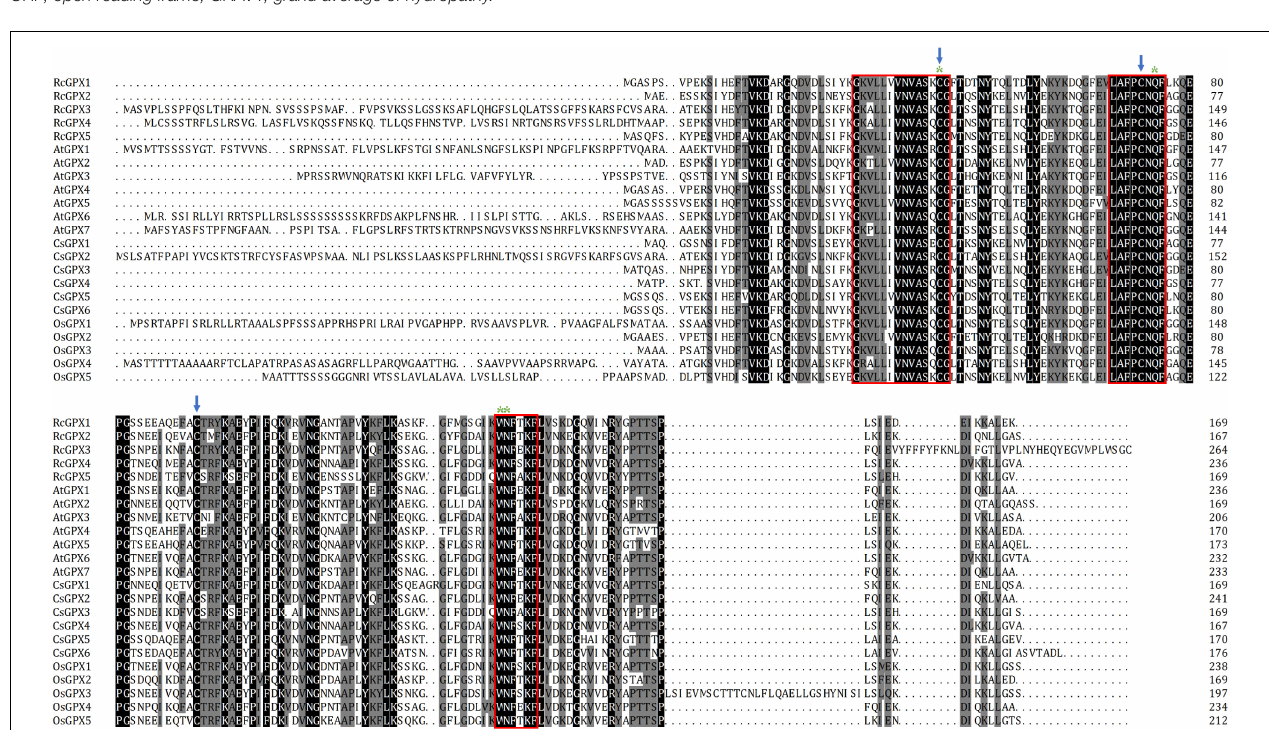
FIGURE 1 | Multiple sequence alignments of the GPXs from the castor bean, cucumber, Arabidopsis, and rice. The three conserved domains found in most animal and plant GPXs were indicated with red boxes; the three conserved Cys residues of the plant GPX proteins were indicated with blue arrows. The amino acid residues that formed a potential redox center were indicated with asterisks. GPXs, glutathione peroxidases.